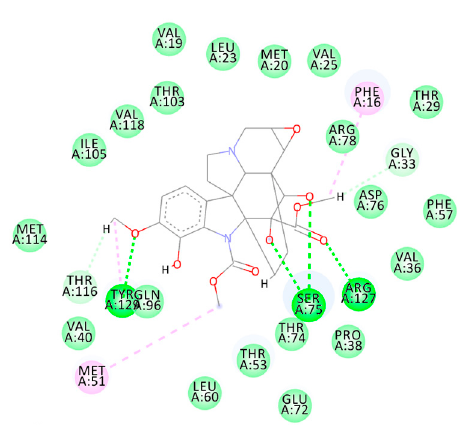
Figure A2. Alkaloids with the lowest energy values regarding molecular docking. The light green represents the van der Waals interactions, the green represents the conventional H-bonds, the pink represents the pi interactions, and the blue represents the water H-bond interactions.